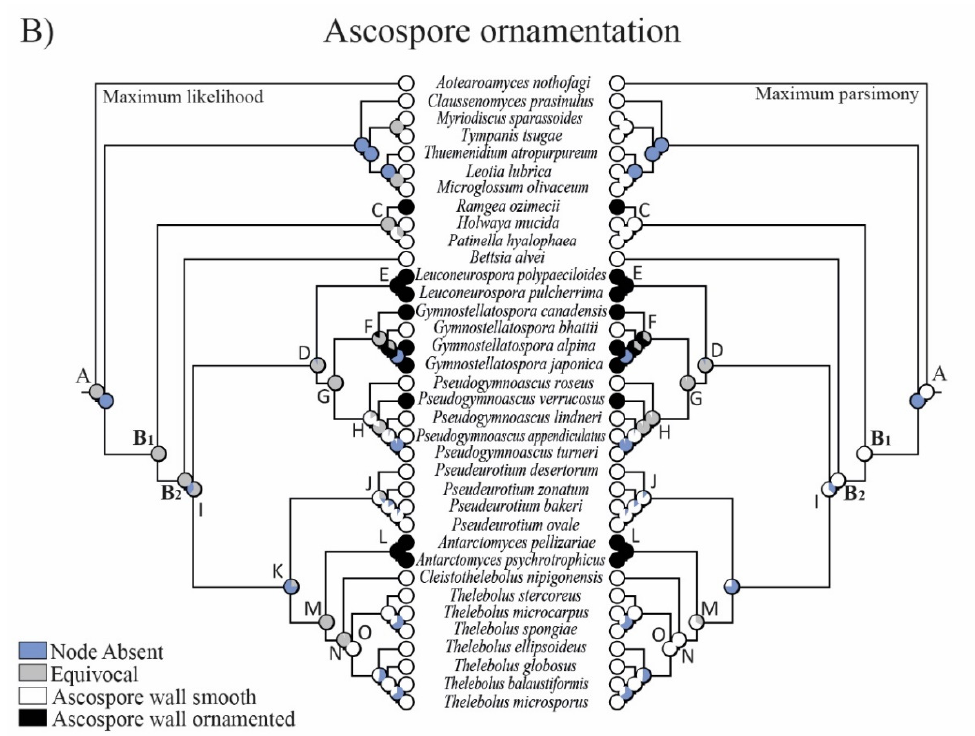
Figure 4. Evolution of ( A ) ascospore color and ( B ) ornamentation using parsimony and likelihood methods across 8000 BMCMC trees obtained from MrBayes. Pie charts at each node illustrate the likelihood (left) and parsimony (right) reconstruction and the proportion of the average received by each character state as the ancestral character of a given clade. Node absent indicates the proportion of nodes with posterior probabilities < 0.95 across trees. Equivocal indicates the same probability for the different features (not resolved).